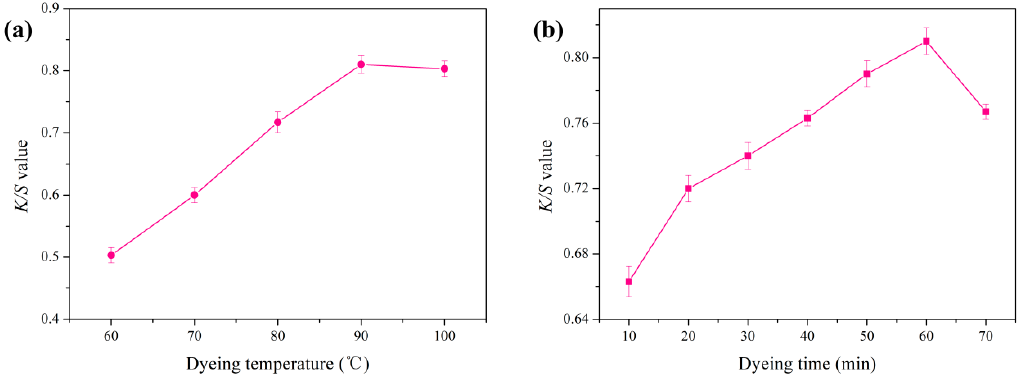
Figure 8. Effect of dyeing temperature ( a ) and dyeing time ( b ) on the K/S value of dyed cotton.